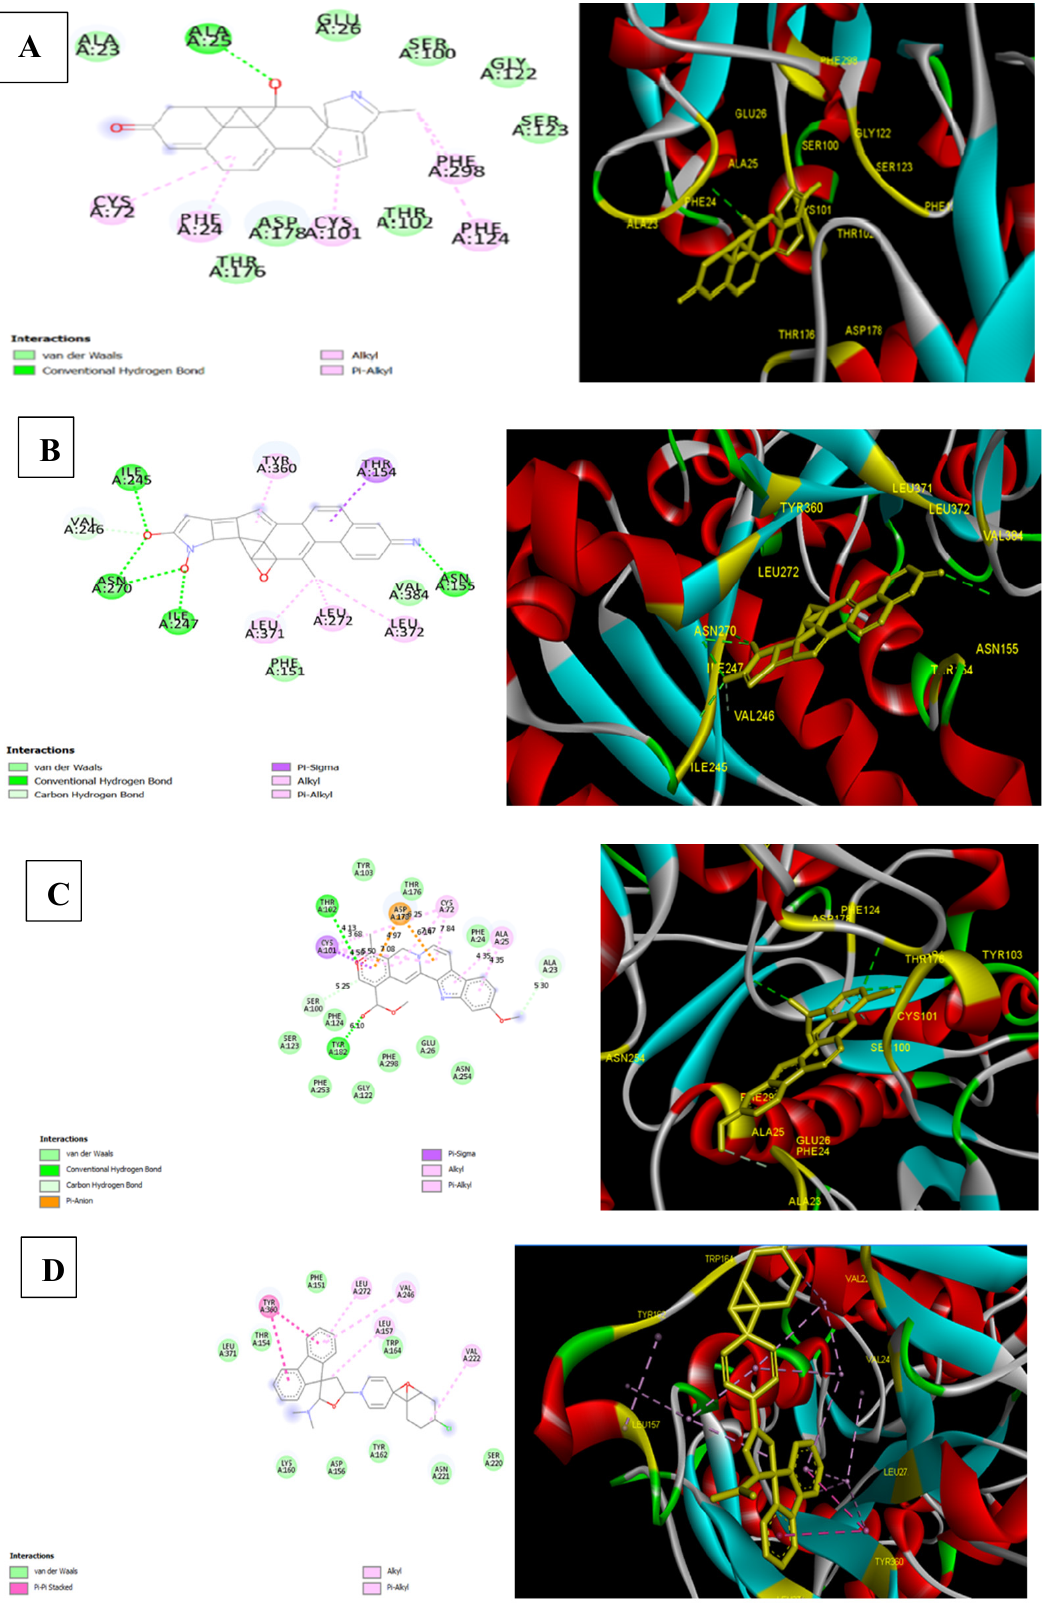
Figure 5. Visualization of the interaction between the ligands selected as lead compounds and the ECD and Hydrogen bond detection using Discovery Studio. ( A ) Holanamine; ( B ) Holadysenterine; ( C ) Pubescine; ( D ) Control Drug-Loperamide